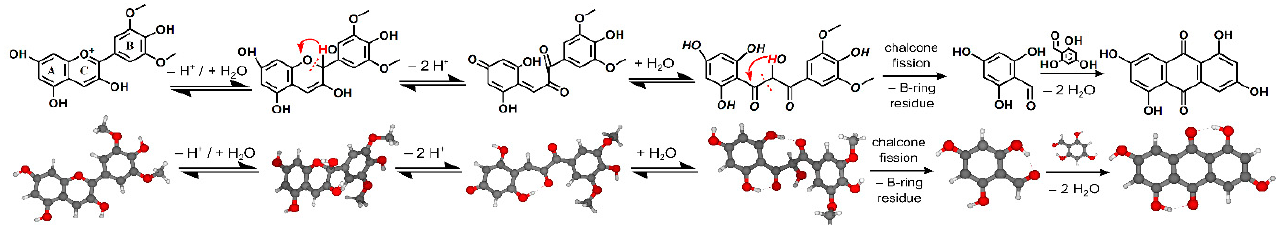
Figure 1. Proposed process of anthrachrysone formation from anthocyanin (malvidin) via phloroglucinaldehyde. Hydroxylated anthraquinones (HAQs) belong among natural dyes. Madder root